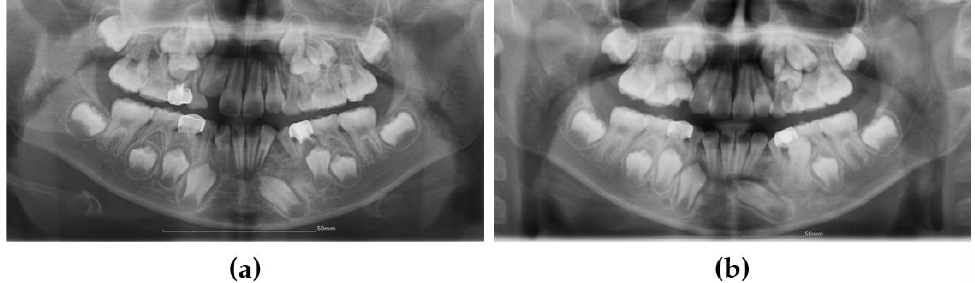
Figure 2. Panoramic radiographs. ( a ) At the time of the first visit, the left mandibular canine was directed to incisors, and an abnormal trabecular bone pattern was present between the lateral incisor, primary canine, and permanent canine; ( b ) Ten months after excision of the cemento-ossifying fibroma, COF, the left mandibular canine appeared impacted, and the first premolar had erupted distobuccally.